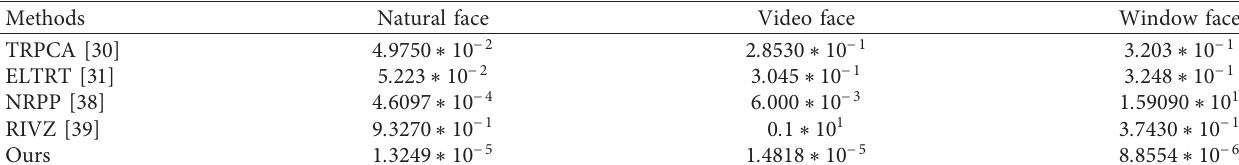
Table 1: Mean square